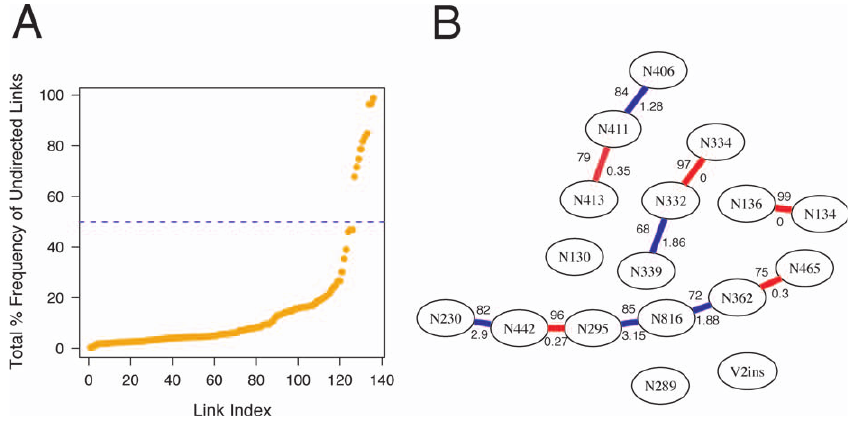
Figure 2. Consensus Bayesian Network of Highly Polymorphic PNGSs in the HIV-1 Envelope (A) Ordered distribution of frequencies that undirected links (i.e., arcs) occurred in replicate networks optimized on 100 random samples of 200 sequences from the alignment, expressed as a percentage ( y -axis). A dotted line at 50% indicates an arbitrary cutoff, above which arcs were applied to assembling the consensus network. (B) Graph of consensus network. Each node (oval) represents the PNGS identified by its position in the HxB2 reference sequence, with one exception (V2ins) that represents an inserted PNGS downstream of the conserved N186. Arcs between nodes are labeled with percentage of occurrence above and odds-ratios below. An odds-ratio , 1 (red) indicates mutual exclusion and . 1 (blue) co-occurrence of PNGSs.